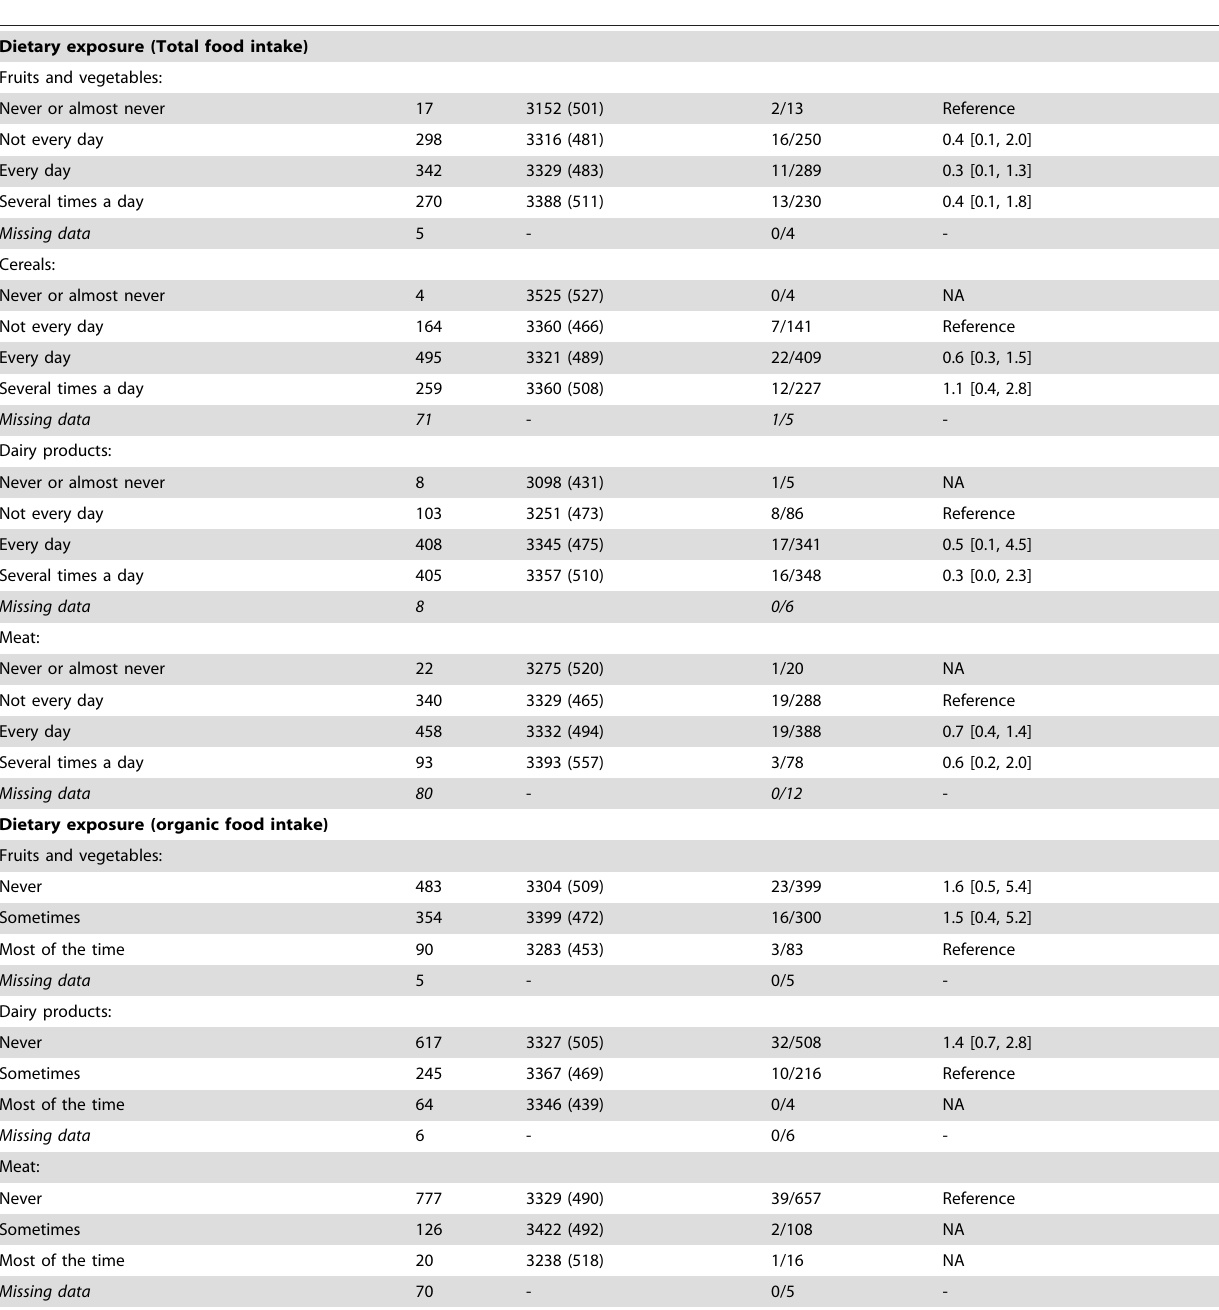
Table 8. Multivariate associations between (i) variables related to in utero exposure to pesticides, (ii) birth weight (BW, in g) and low birth weight (LBW)